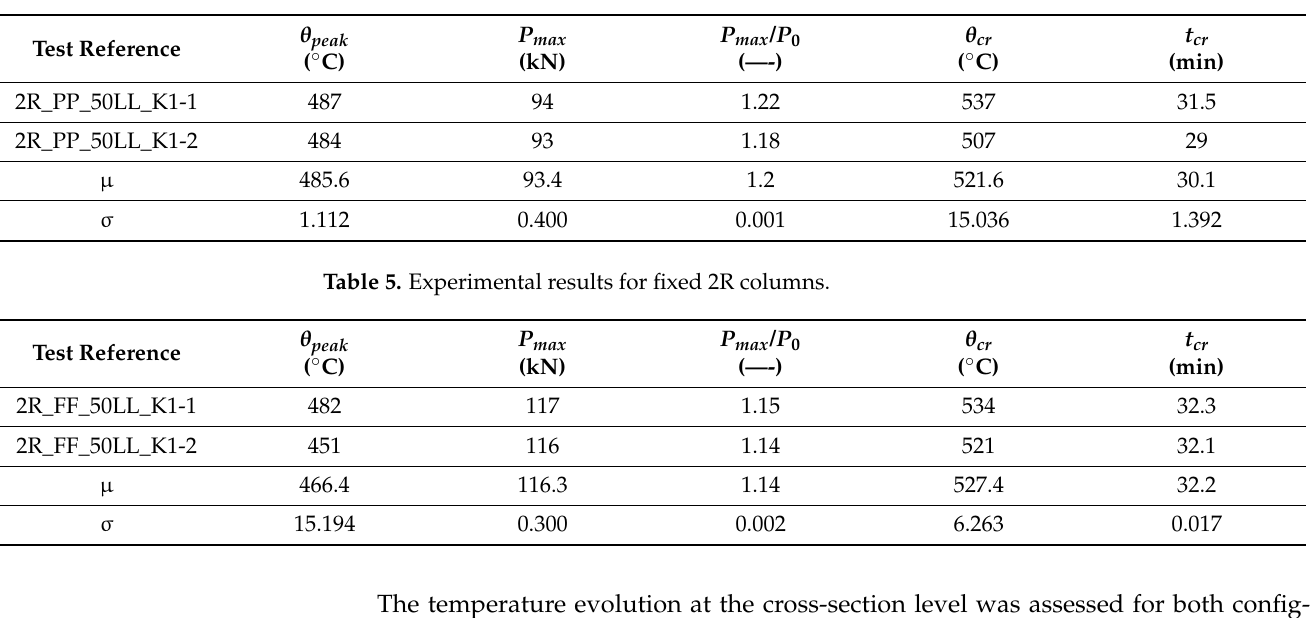
Table 4. Experimental results for pinned 2R columns.